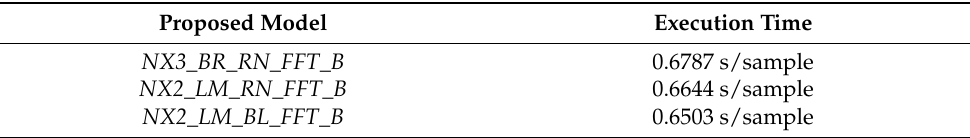
Table 2. The execution time for the 3 best-proposed models.